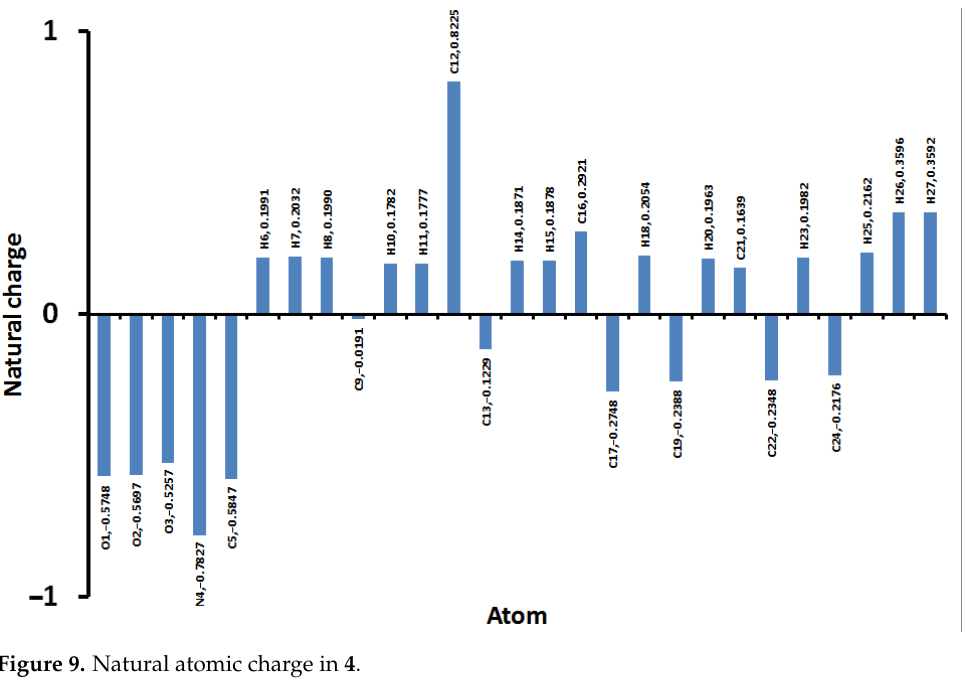
Figure 9. Natural atomic charge in 4 .